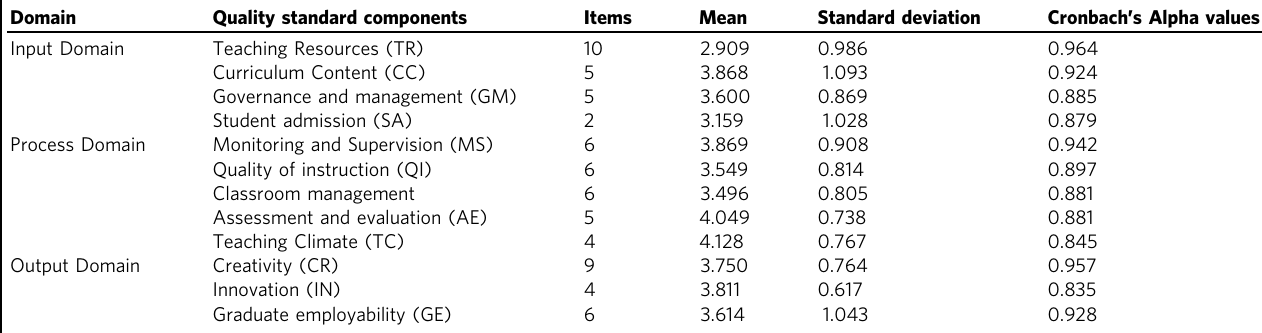
Table 11 Reliability coef fi cient, mean and standard deviation values.